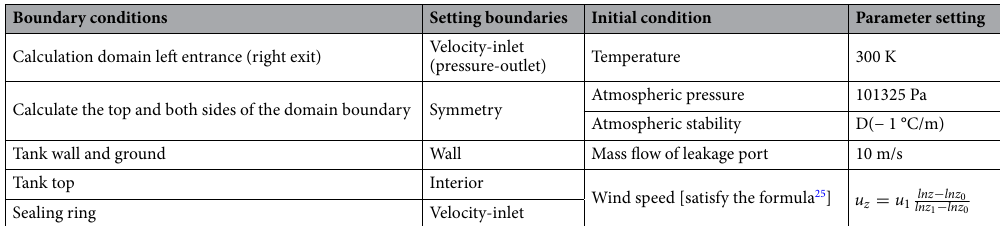
Table 1. The setting of boundary conditions and initial conditions. Model and algorithm: k-ε model, Simple standard